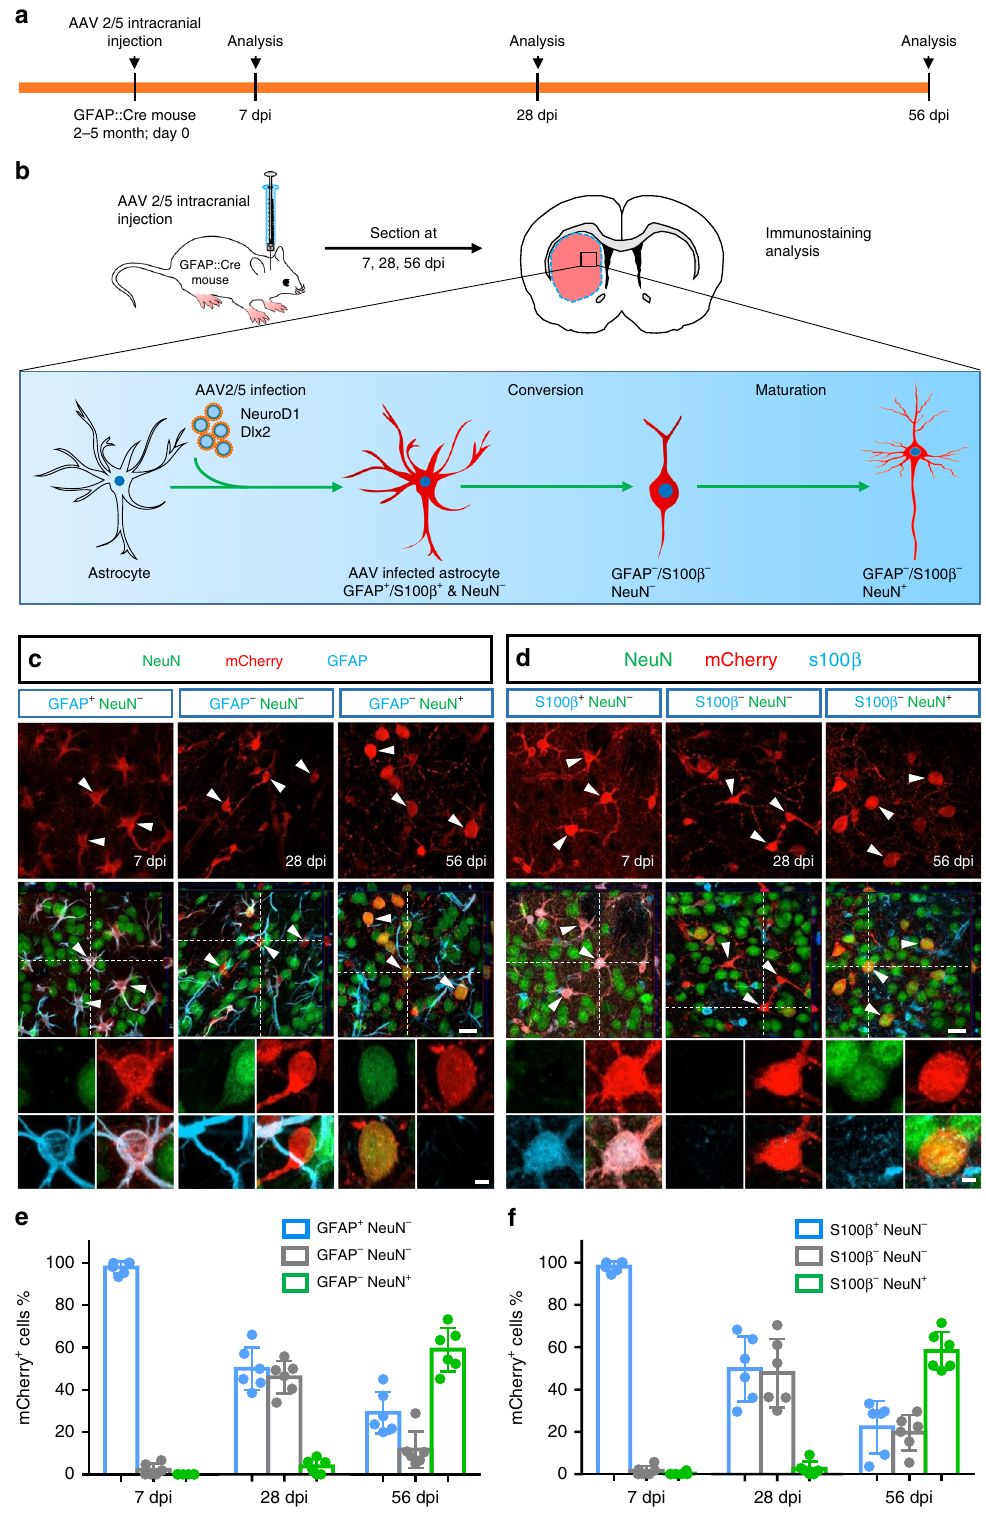
neurons immunopositive for PV (8.4%, n = 9 mice; Fig. 4e, f),